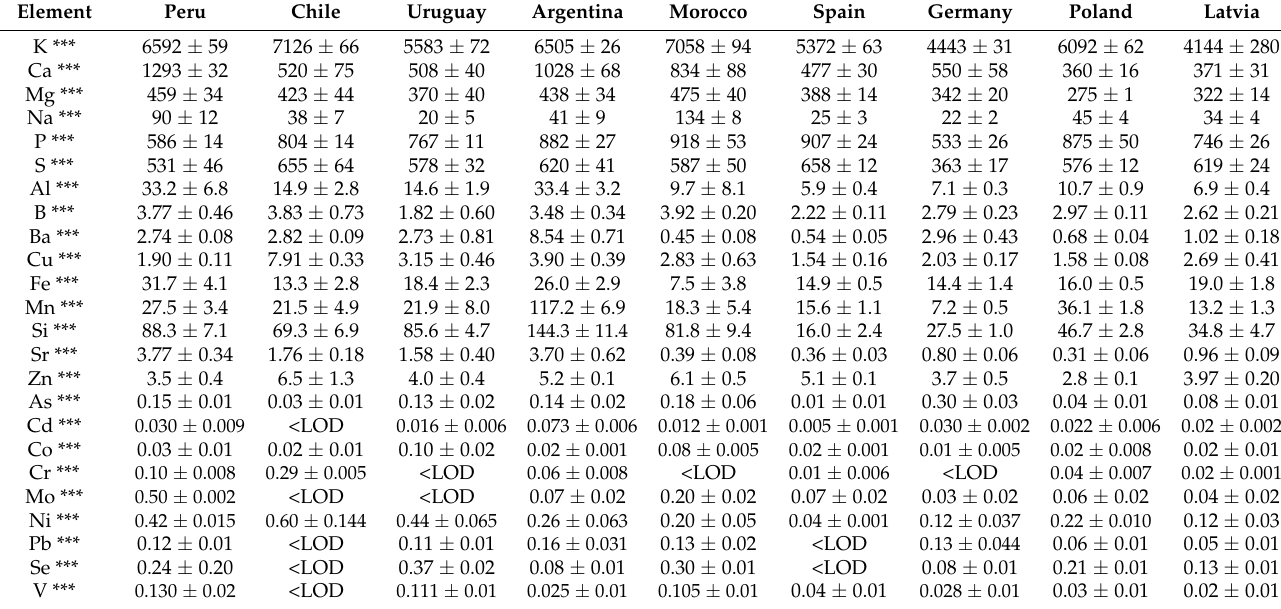
Table 2. Concentrations (mg/kg) of elements in blueberry samples from different countries.